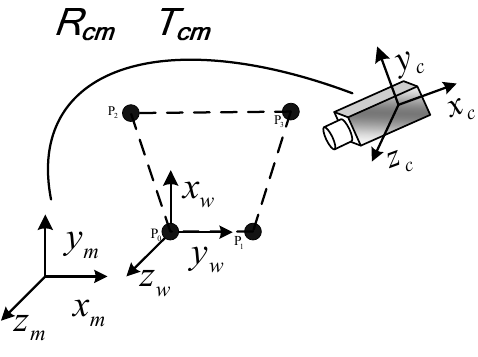
Figure 2. The rotation and translation coordinate system.